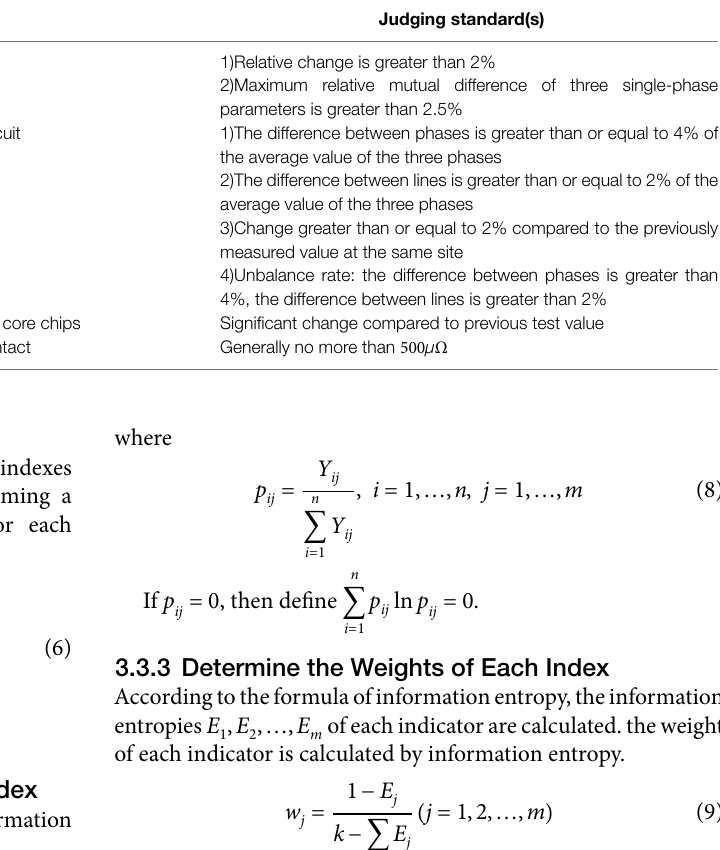
TABLE 2 | Transformer fault assessment standards.